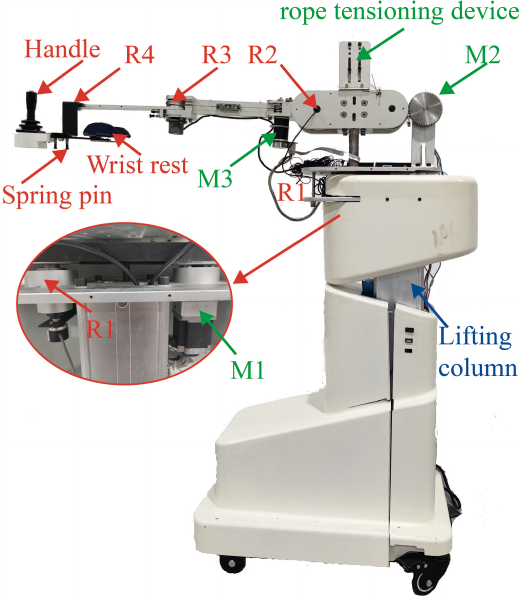
Figure 5. The structure of the end-effector-based upper limb reha- bilitation